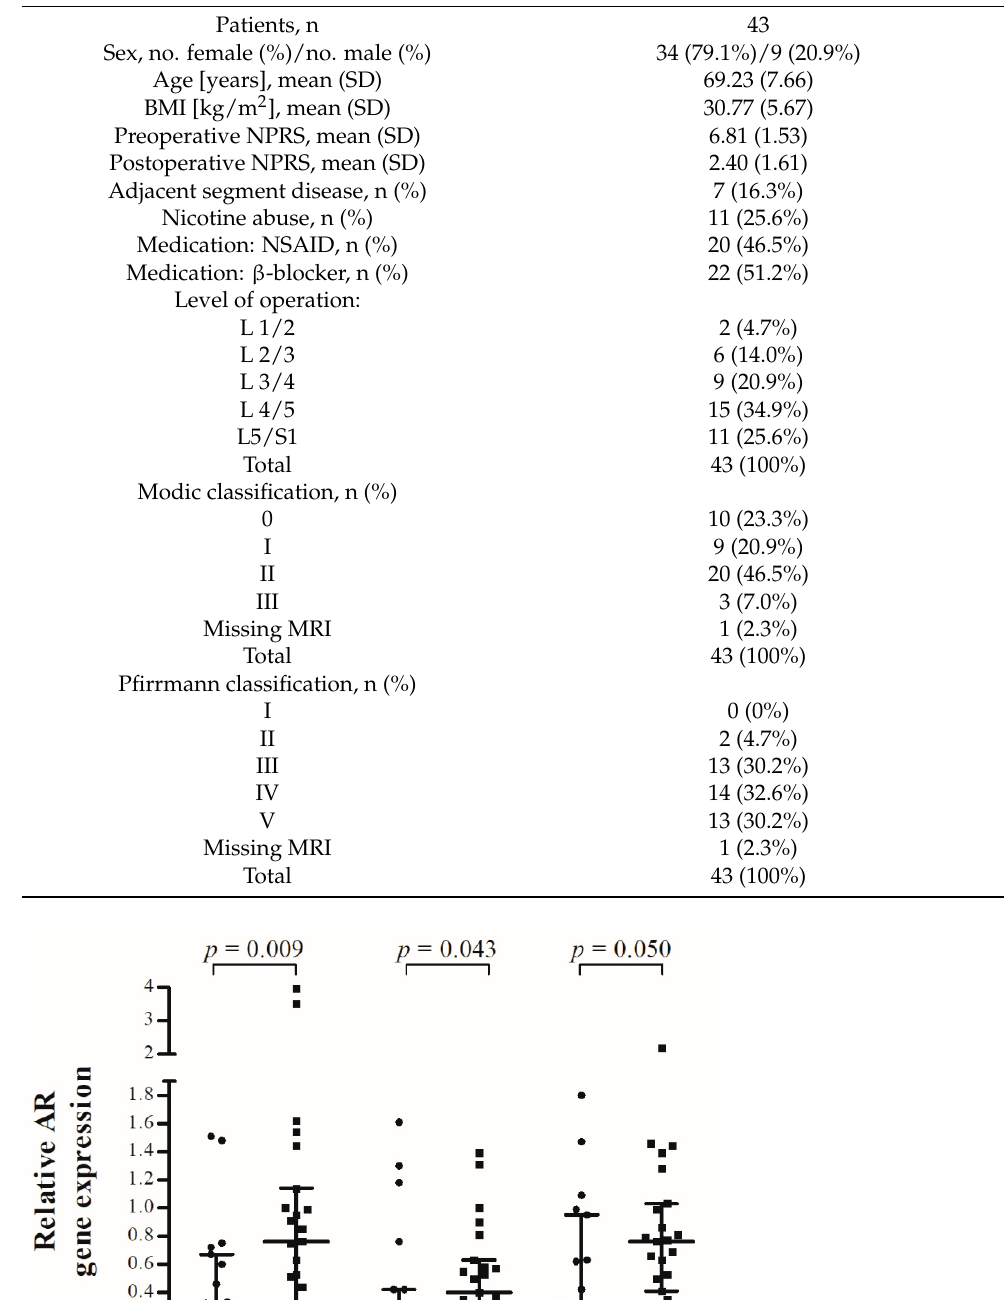
Table 1. Patient Characteristics, Radiological Classification Systems and Medication.